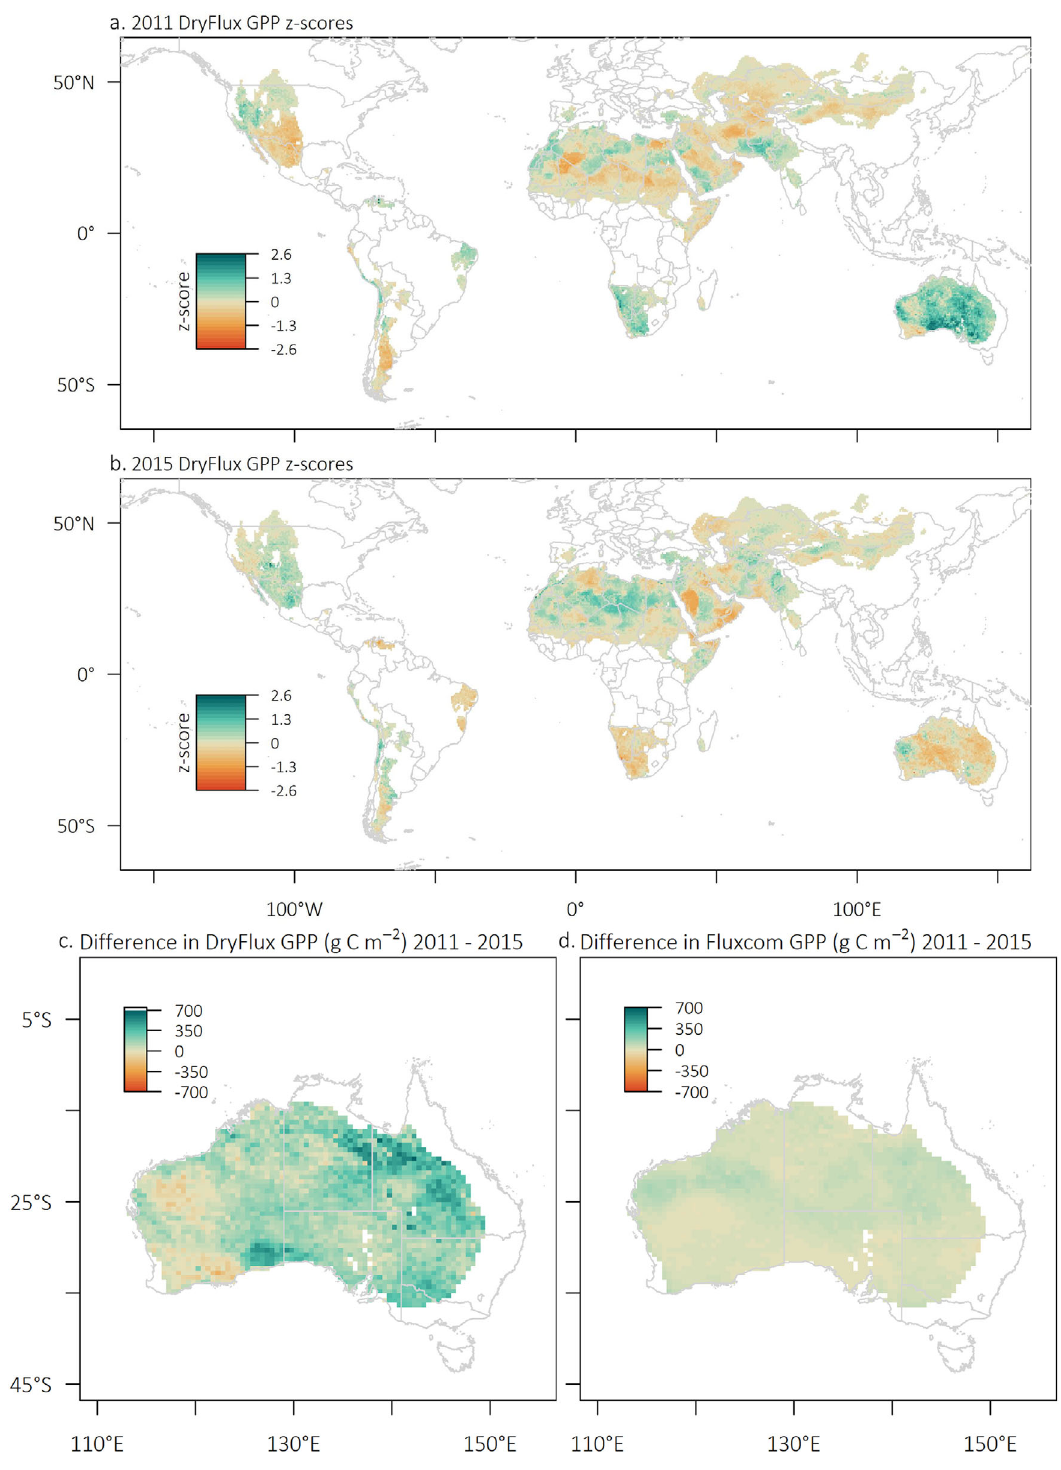
Fig. 3 Gross primary productivity in global drylands and Australia. a , b Z -scores of annual DryFlux GPP in global Drylands for 2011 (a strong La Niña year) ( a ) and 2015 (a strong El Niño year) ( b ). c , d Difference in carbon uptake over Australia (gCm − 2 year − 1 ) between 2011 and 2015 using DryFlux ( c ) and FLUXCOM ( d ) GPP estimates (2011 minus